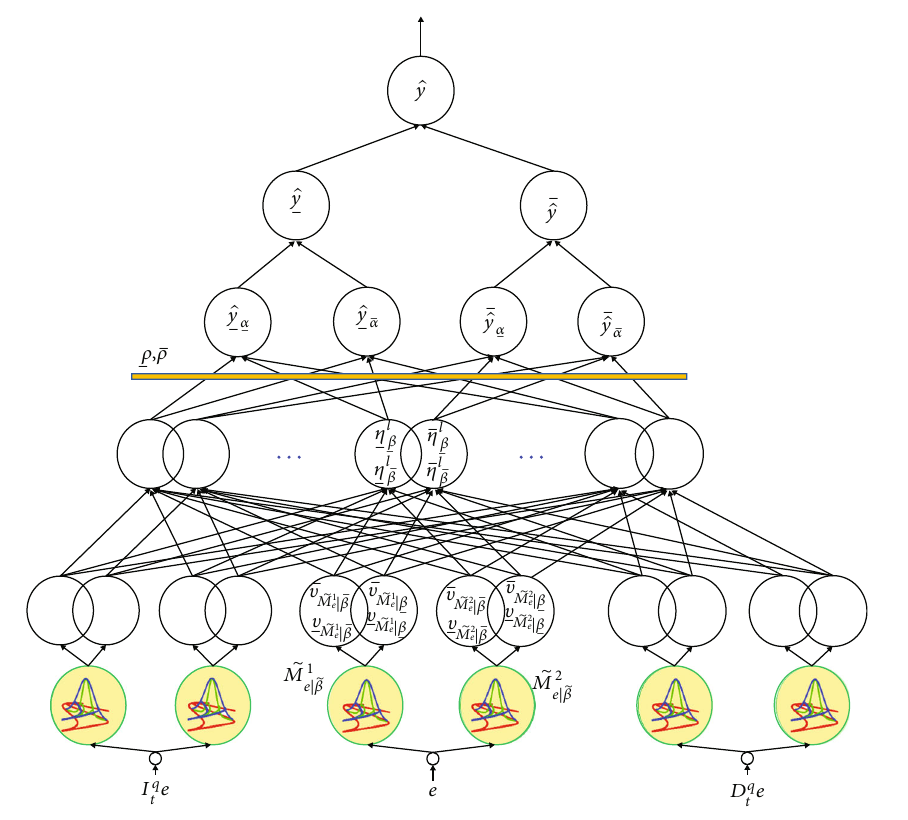
Figure 3: A general view on